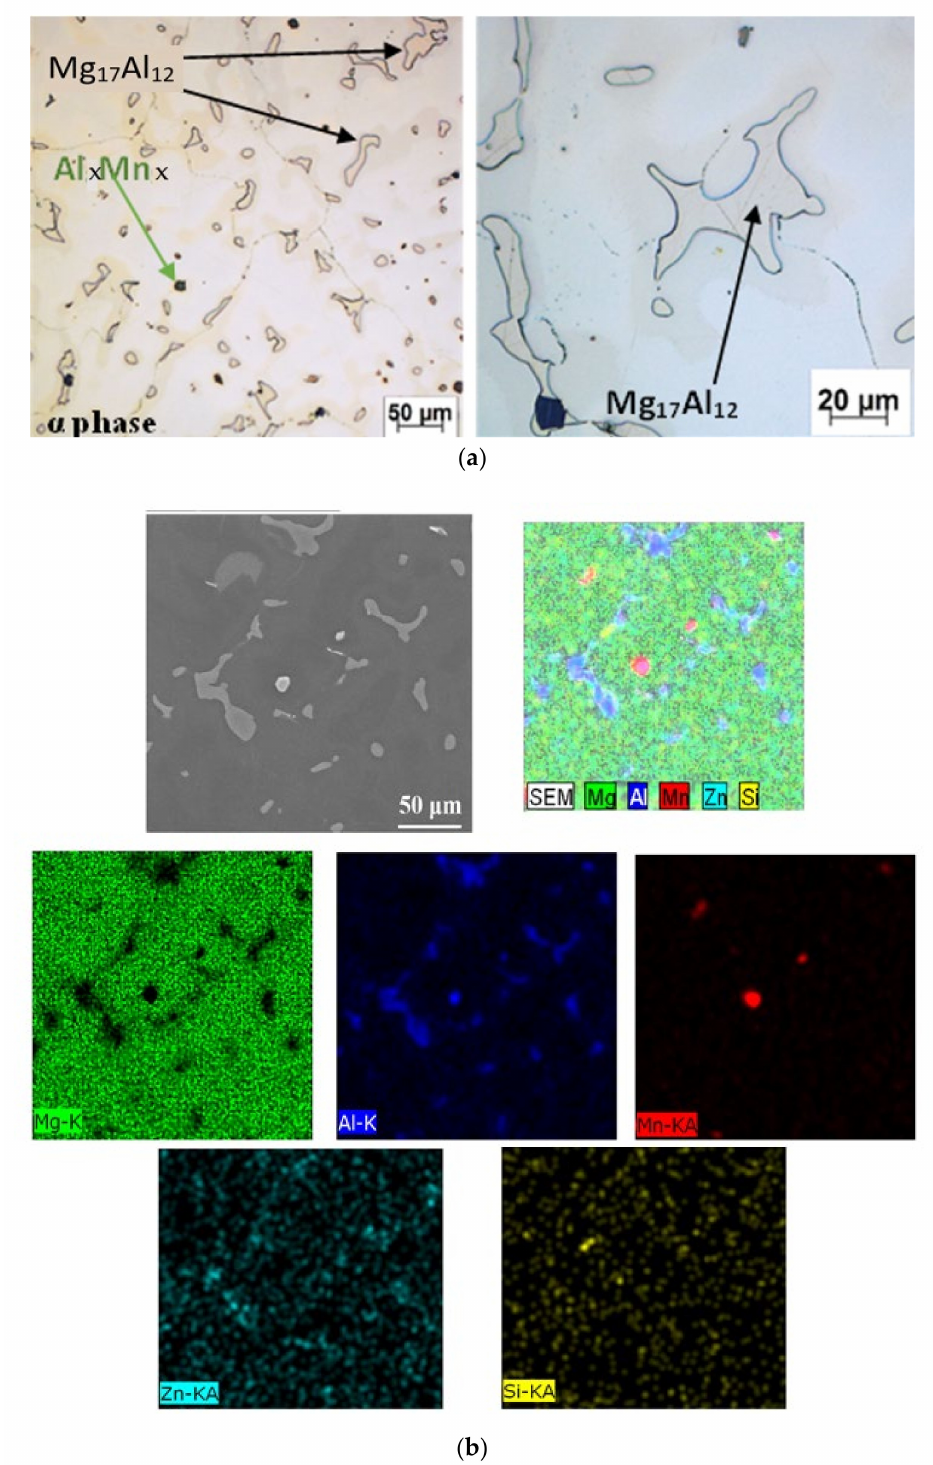
Figure 3. Microstructure and chemical composition of AZ91, Nital 2% ( a ) α -phase together with inter- metallic phases, ( b ) EDX analysis of the microstructure chemical composition of various